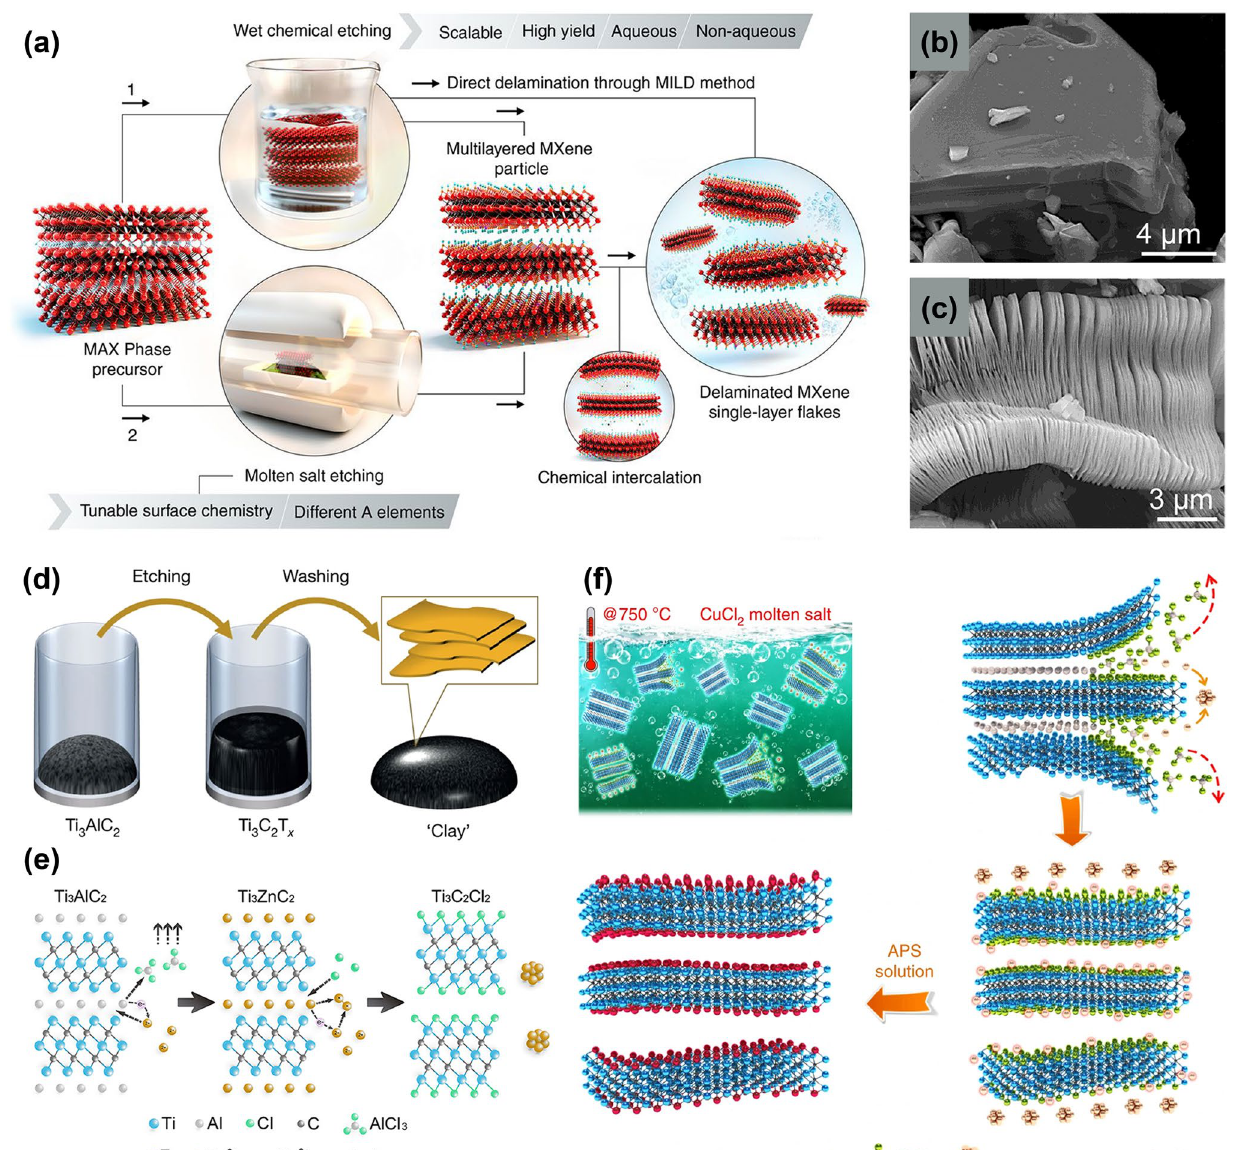
Fig. 2 a Schematic illustration of two approaches to produce MXenes by removal of A layers from MAX phases and related layered compounds [35]. Copyright 2021, The American Association for the Advancement of Science. b SEM image of Ti 3 AlC 2 particle before HF treatment;